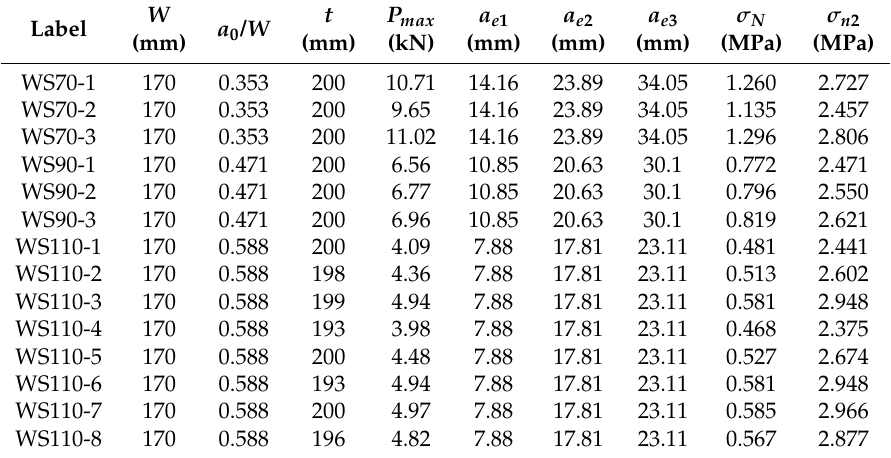
Table 3. Geometry, test results and equivalent crack length of wedge-splitting specimens